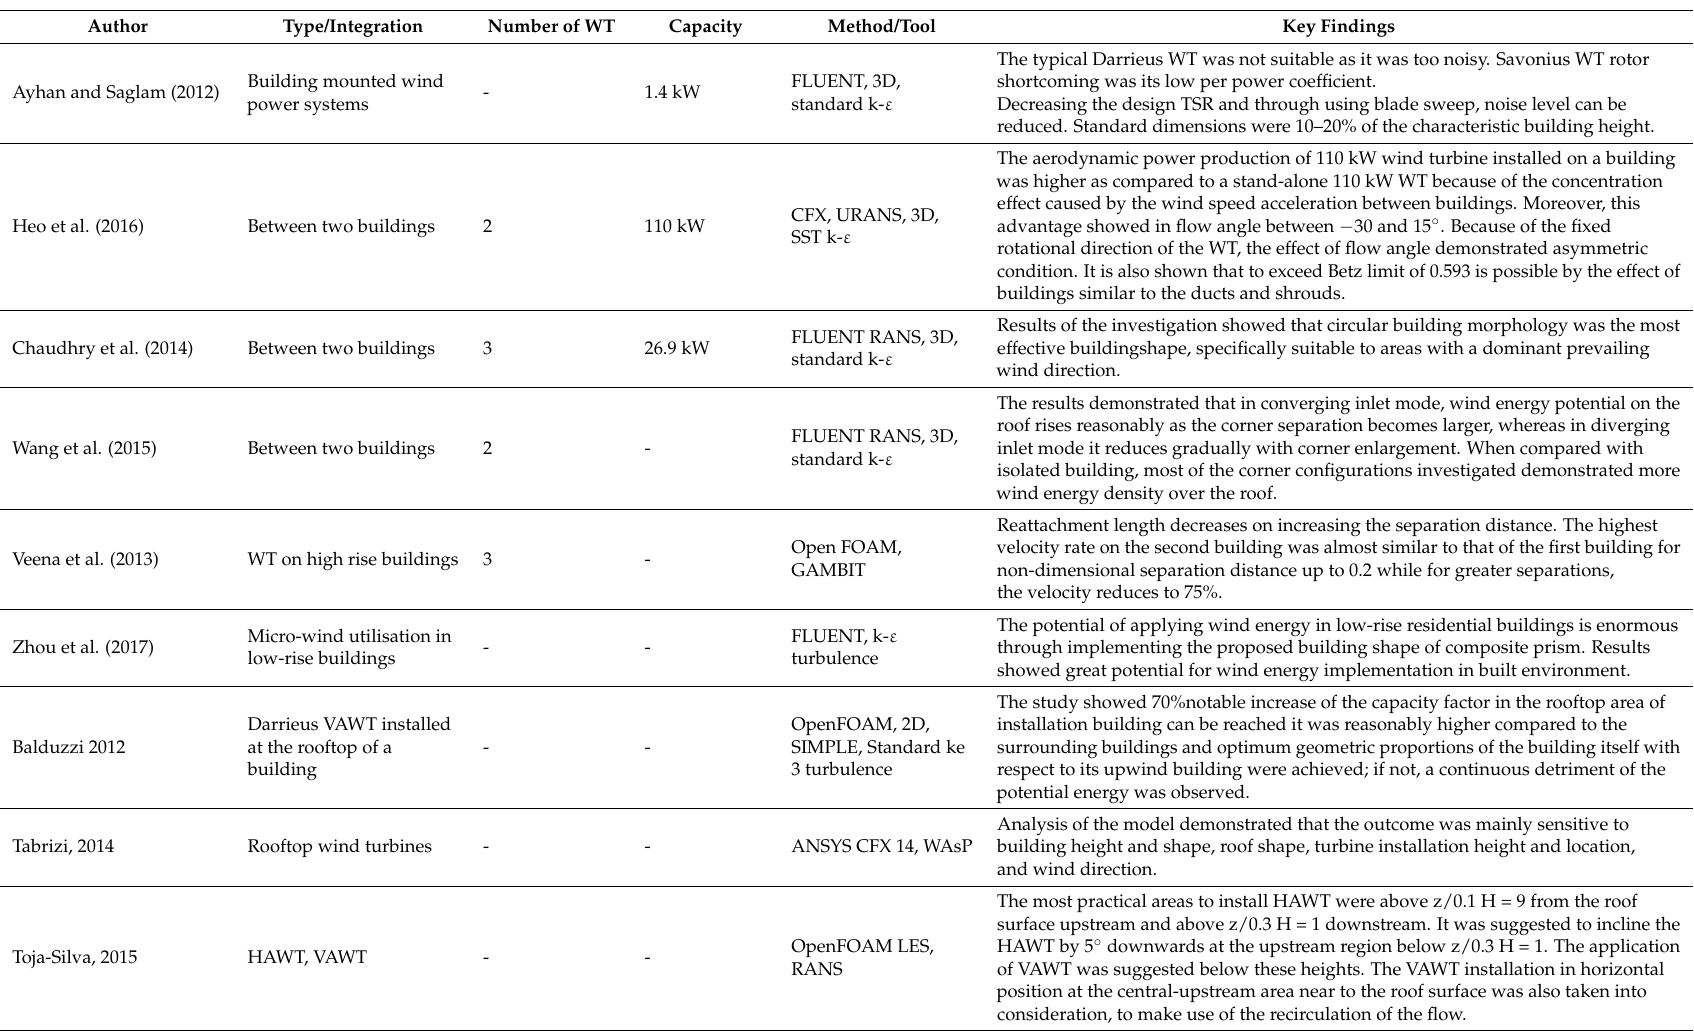
Table 2. Wind Turbine Assessment—Building Mounted Wind